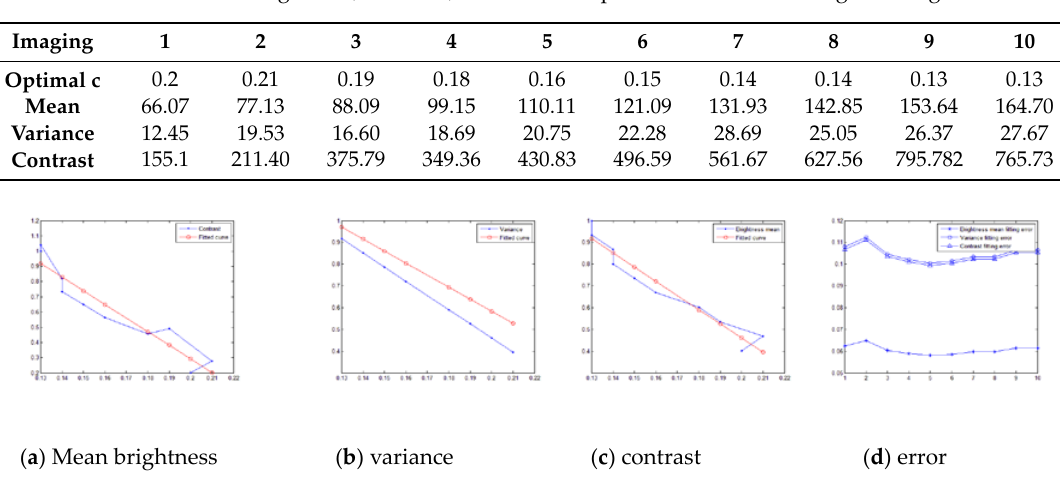
Figure 10. ( a – d ) Mean brightness, variance, contrast and fitting curve.